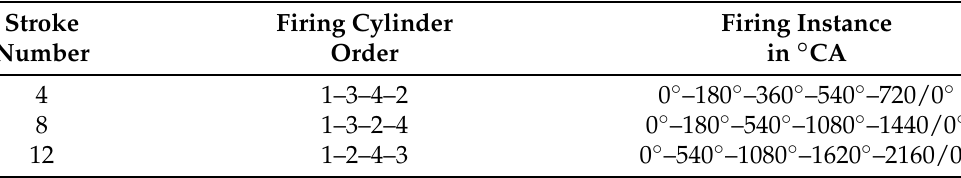
Table 5. Firing orders and intervals for different stroke